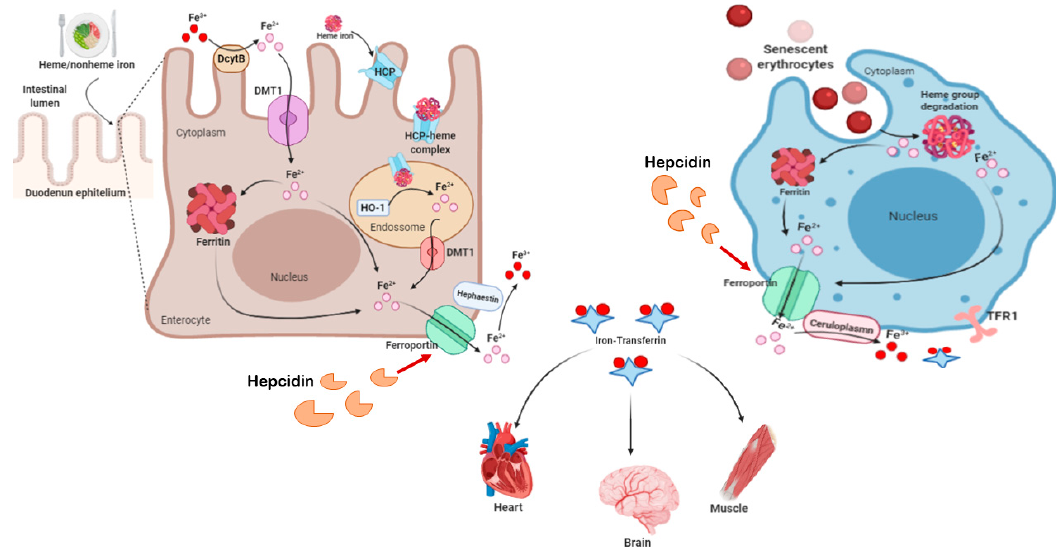
Figure 3. Human Iron metabolism. Iron concentration in the body is maintained through diet and the recycling of senescent erythrocytes. The daily diet provides approximately 1–2 mg of iron. Enterocytes, present in the duodenum and in the proximal portion of the jejunum, can absorb both ferrous iron (heme iron) and ferric iron (non-heme). However, it is necessary to reduce ferric iron to ferrous iron, by apical ferric reductase enzymes, such as enzyme duodenal cytochrome b (Dcytb), for absorption to occur. Then, iron is transported by the divalent metal type transporter-1 (DMT-1) and stored inside the cell [86]. Ferrous iron from the diet is internalized by the heme-1 carrier protein (HCP) in cells, where it is stored as hemosiderin and/or ferritin, to prevent the Fenton reaction. Physiologically, iron stores are mobilized from intracellular to the extracellular by ferroportin (FPN) when the serum iron is low. Iron released in its ferrous state is oxidized to ferric iron and binds to serum apotransferrin to be transported through the body, giving rise to holotransferrin. This oxidation reaction occurs through the action of oxidase enzymes: hephestine present in enterocytes, ceruloplasmin present in hepatocytes macrophages. The distribution of iron to the tissues occurs through the endocytosis of holotransferrin, mediated by the binding to transferrin receptors type 1 (TFR1) and type 2 (TFR2). Ferroportin mediates the efflux of iron within cells, maintaining systemic iron homeostasis. This process is negatively regulated by hepcidin, which promotes ferroportin endocytosis and then proteolysis in lysosomes by induced ubiquitination [83]. The recycling of iron by macrophages occurs through the phagocytosis of senescent erythrocytes and hemoglobin and the heme group of intravascular hemolysis. Once internalized in the macrophage, the heme group releases ferrous iron through the activity of the enzyme heme oxygenase, which can be exported to the extracellular medium by ferroportin or stored as ferritin [83,84].